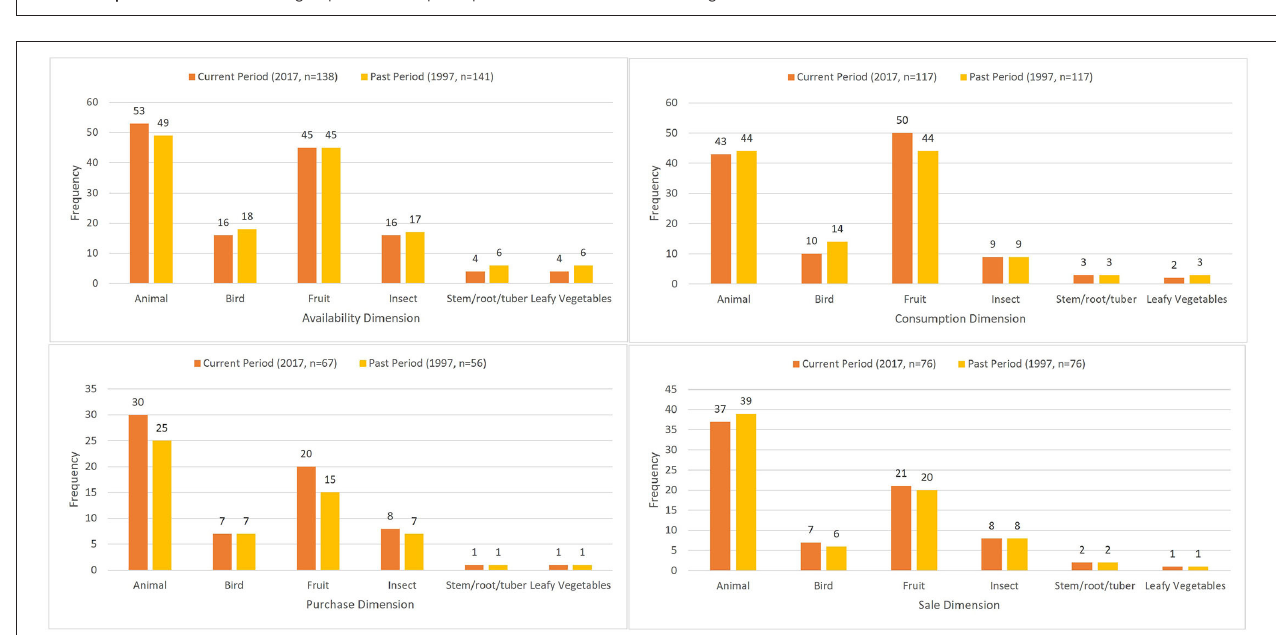
FIGURE 8 | Quote of female focus group discussion participant about sales in Teso sub-region.